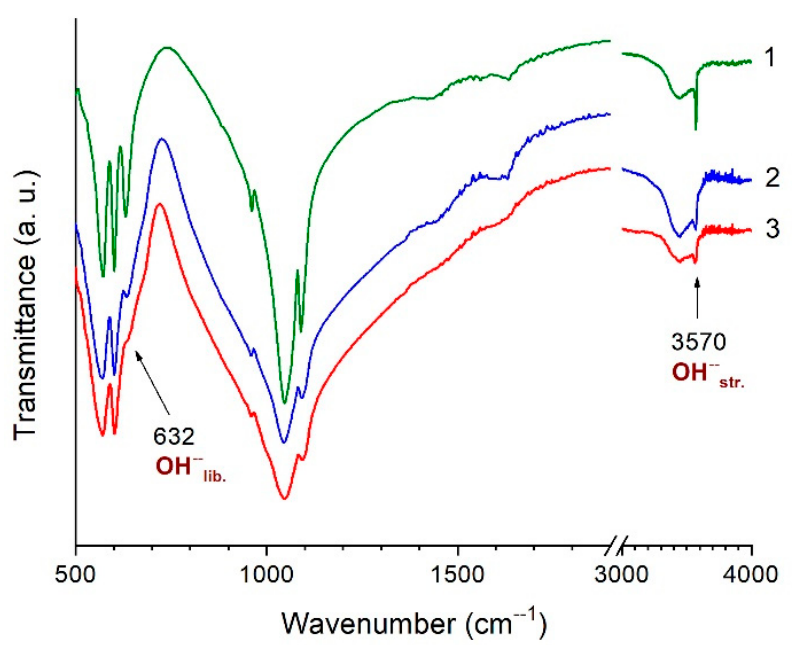
Figure 7. IR spectra of HA samples after heating under different conditions: (1) pellet, heating in